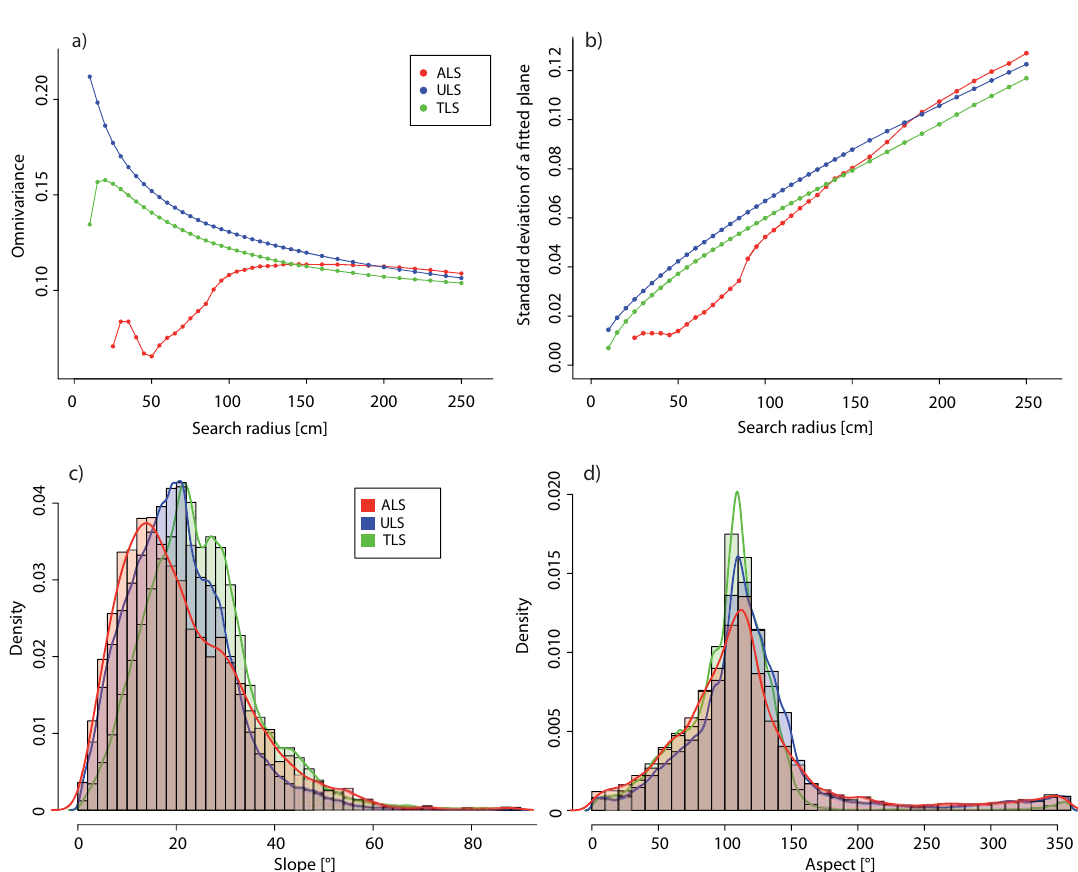
Figure 4. Median (a) omnivariance values and (b) standard deviations of distances from points to the fitted plane calculated by using different search radii for a subset of ALS, ULS and TLS point cloud data. Histograms showing frequency density of (c) slope angles and (d) aspect angles of fitted planes within a 150cm spherical neighbourhood occurring within the same point cloud subset but acquired with different laser scanning